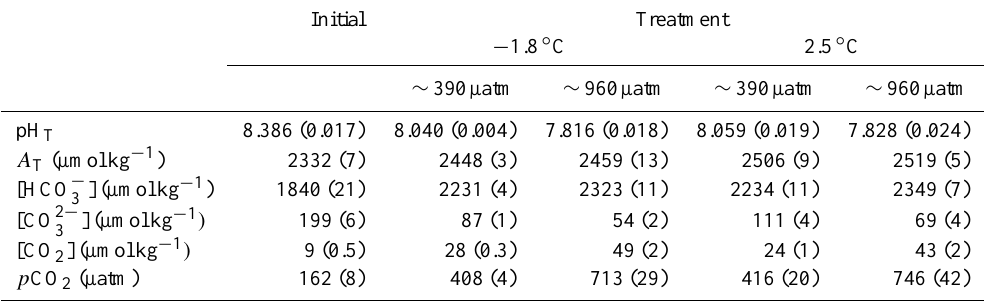
Table 2. Measured and calculated mean values of pH T , A T , [HCO − (before aeration of the medium) and after 14 days of treatment in Experiment A. Values within brackets represents standard error ( n = 4).